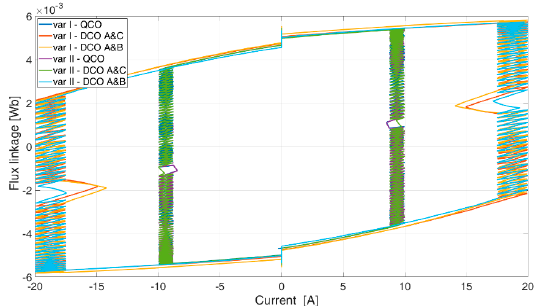
Figure 13. Flux linkages vs. rotor positions for all configurations.